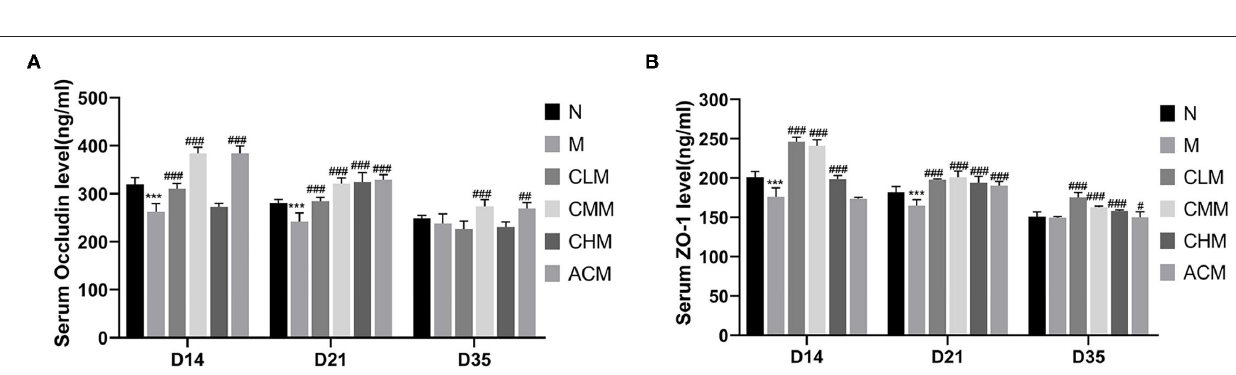
FIGURE 5 | Effects of CSP on serum and Occludin (A) and Zo-1 (B) levels. Data are expressed as mean ± SD. *** p < 0.001 compared with N group; # p < 0.05, ## p < 0.01, and ### p < 0.001 compared with M group. similar to those in group N, and the intestinal injury symptoms were recovered ( Figures 6 , 7